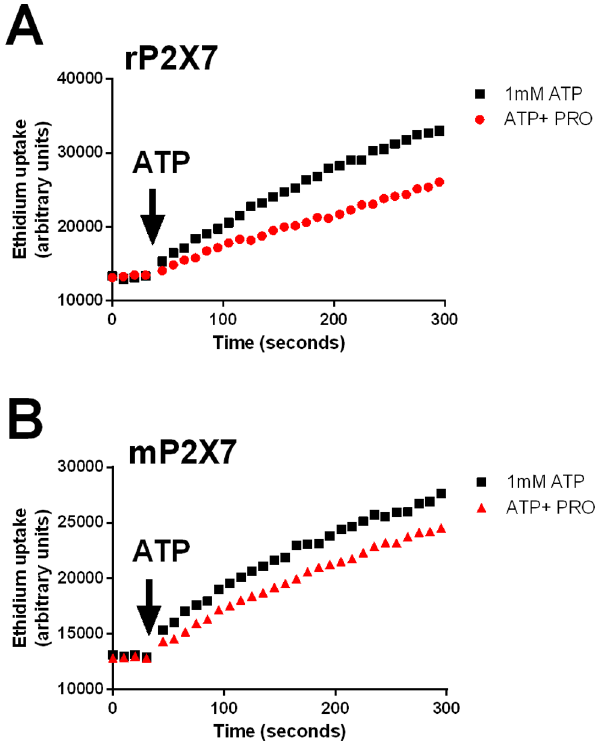
Figure 3. Probenecid shows minimal inhibition of ATP-induced dye uptake in HEK-rat P2X7 and HEK-mouse P2X7 cells. Ethidium + uptake was induced in (A) rat P2X7 and (B) mouse P2X7 stable cell lines by the addition of 1 mM ATP (denoted by the arrow) in a low divalent physiological solution. Control ethidium uptake to ATP is shown in black squares and ethidium uptake in the presence of 2.5 mM probenecid (pre-incubated for 10 minutes at 37 u C) is shown in red shapes.